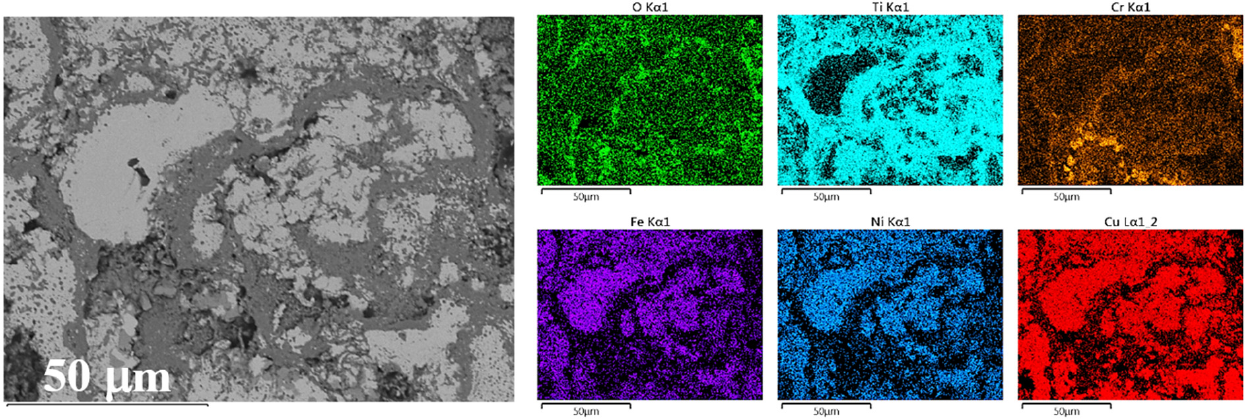
Figure 6. Elemental mapping of CrCuFeNiTi sample.